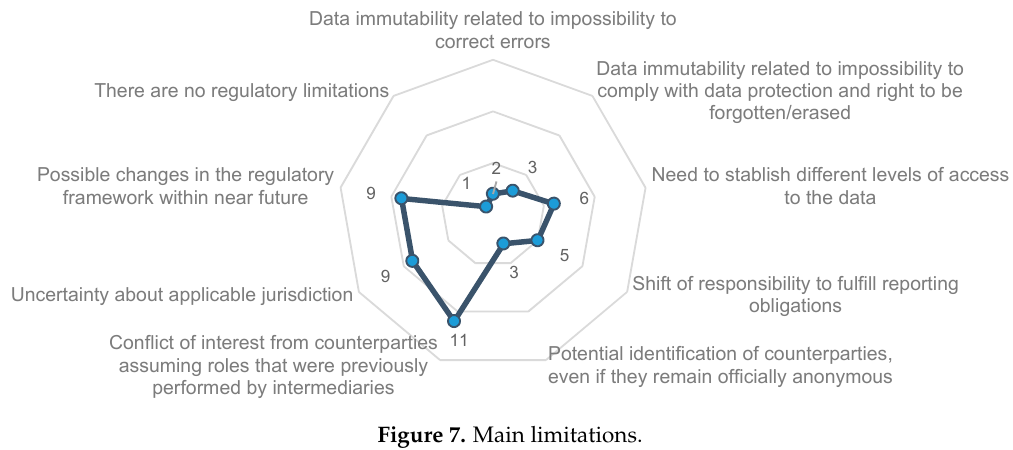
Figure 7. Main limitations.